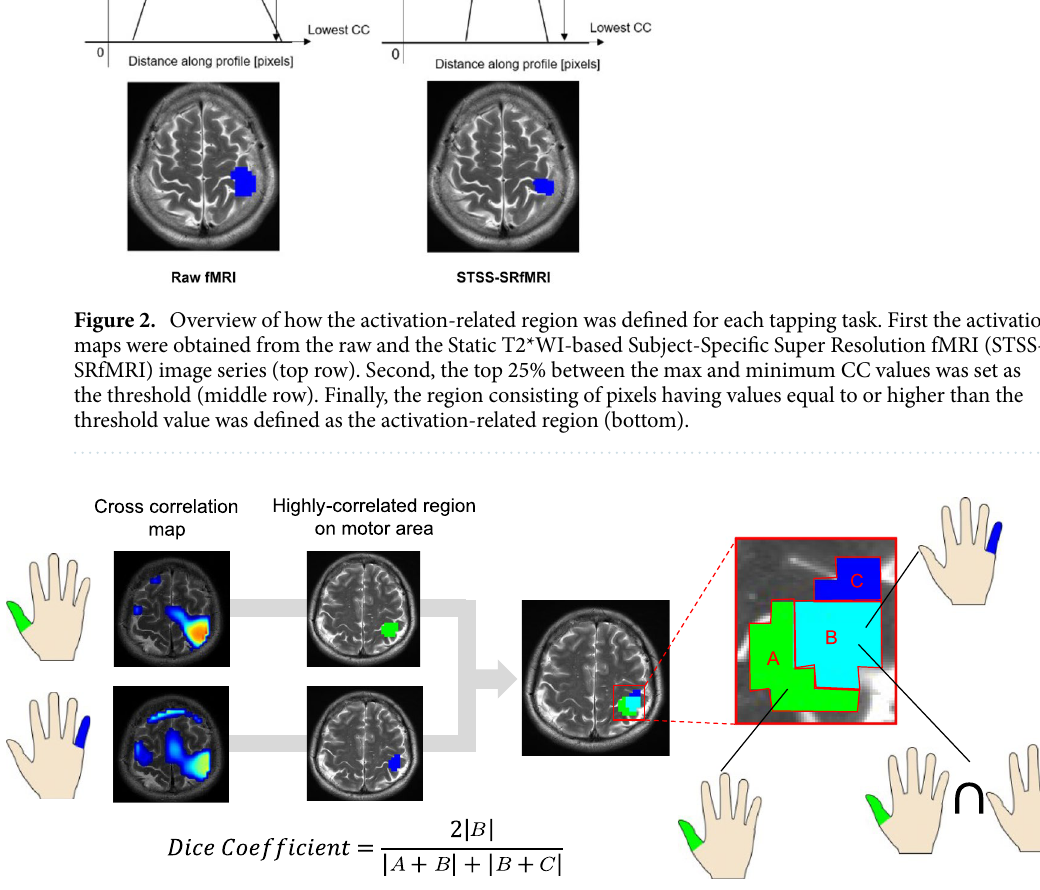
The number of pixels included in the activation-related region of the raw fMRI map was compared to that of the STSS-SR fMRI map for each finger of each subject. As the STSS-SR fMRI maps had pixels that were four times smaller than those of the raw fMRI maps for the same sized area, the number of pixels in the STSS-SR fMRI maps was divided by 4 before comparison. Independence of the extracted activated regions for the different tasks. The raw fMRI and STSS-SR fMRI maps obtained in the previous sub section were compared to determine which of them has a higher functional resolution for the thumb and little finger tasks. For this purpose, a Dice coefficient 21,22 was calculated for the extracted activation-related regions of the thumb and little finger for each subject (Fig. 3). This